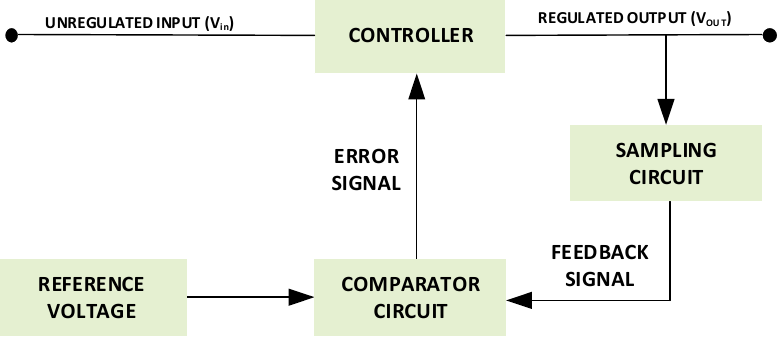
Figure 2. The Block Diagram of a Voltage Regulator.